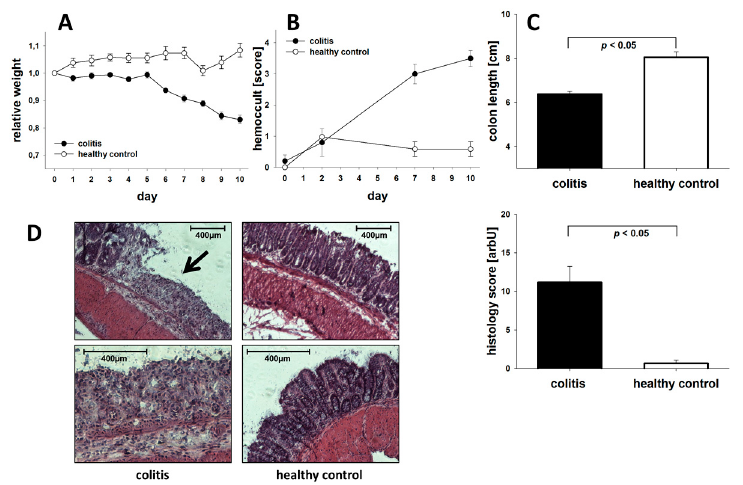
Figure 1. Assessment of clinical course and intestinal histological damage of acute Dextran sodium sulfate (DSS)- colitis. DSS colitis was induced in C57BL / 6 mice by application of DSS (2.5% w / v) in drinking water for seven days. Control mice received drinking water alone. Animals were euthanized at day 10. Shown are data from one experiment (n = 5 per group). Results were confirmed in two experiments. ( A ) Changes in body weight are shown relative to the initial weight. Data were analyzed using ANOVA followed by Student–Neuman–Keul (S.N.K.) post hoc test. ( B ) Fecal blood excretion as determined by guaiac paper test (hemoccult, 0 = negative, 4 = blood macroscopically). Data analysis by ANOVA and S.N.K. post hoc test. ( C ) Post-mortem colon length. ( D ) Histological damage as determined by degree of crypt destruction and extent of inflammation. Shown are representative histological images (haematoxylin / eosin staining; magnifications × 10 of colitic mice or control). Bar graph: Injury score.